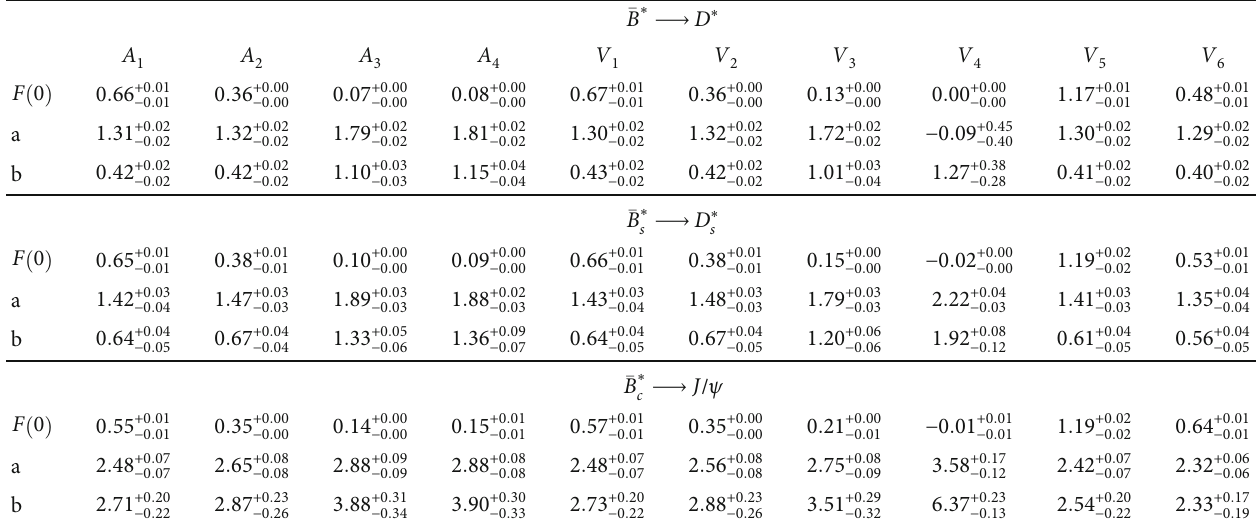
Table 2: The numerical results of form factors for (cid:1) B ∗ ⟶ D ∗ , (cid:1) B ∗ are caused by the Gaussian parameters listed in Table